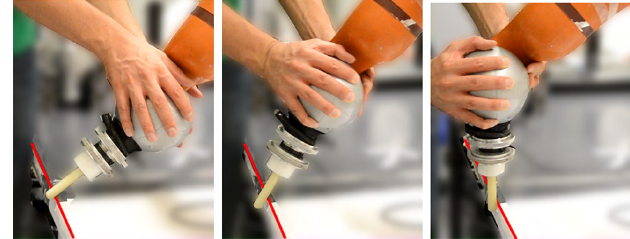
Figure 9. Demonstration by kinesthetic teaching